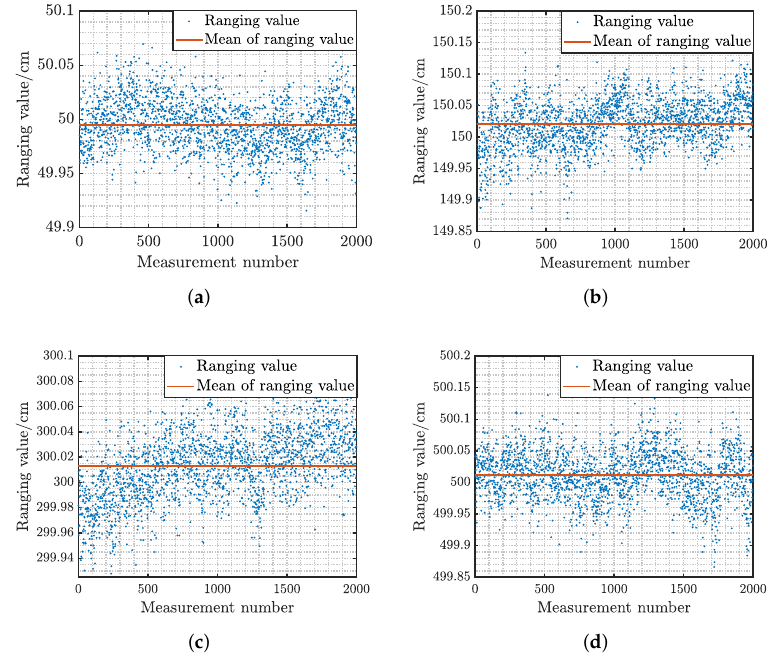
Figure 10. Ranging results at different distances. ( a ) True distance is 50 cm. ( b ) True distance is 150 cm. ( c ) True distance is 300 cm. ( d ) True distance is 500